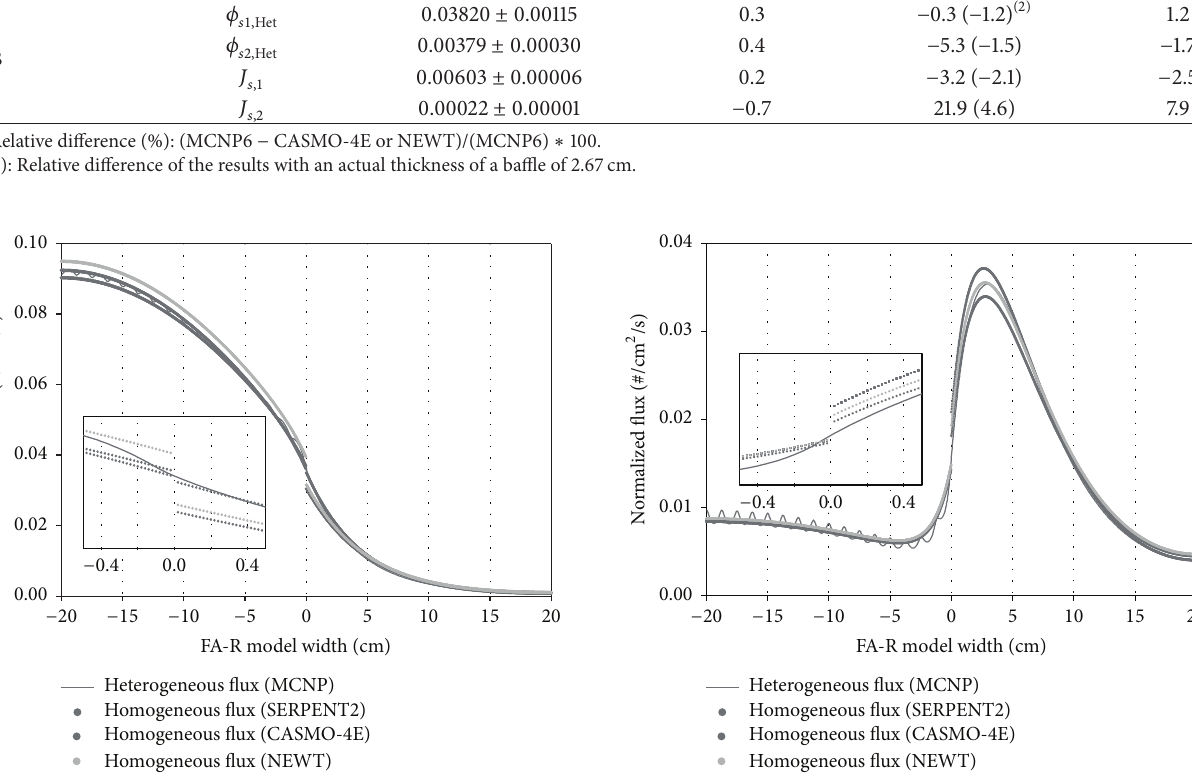
Figure 9: The fast flux distribution and detail view at interface for FA-R model.